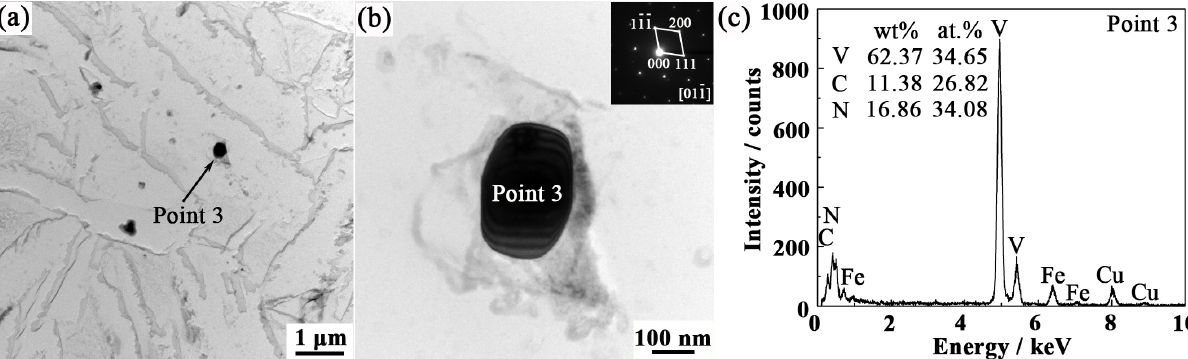
Figure 13: TEM analysis of precipitated particle in the simulated CGHAZ at t 8/5 180 s: (a) the low magnification bright field morphology; (b) the high magnification bright field morphology inserted with SAED pattern; (c) EDS